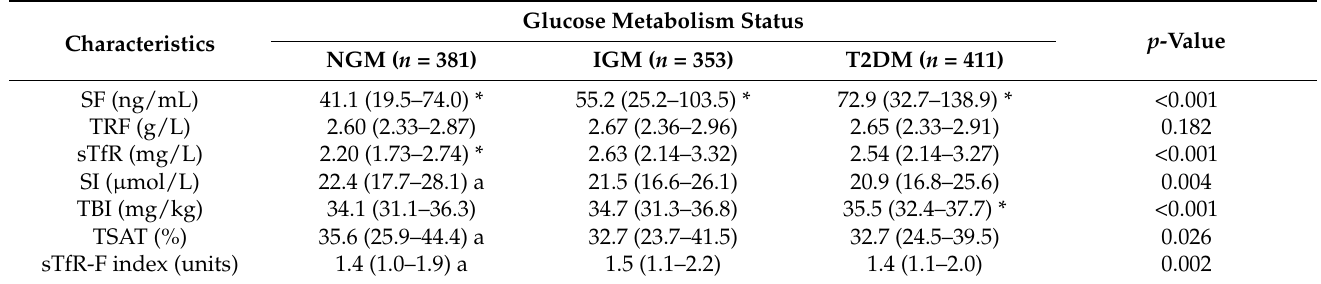
Table 2. Characteristics of the iron status of the studied population (medians and interquartile ranges (P 25 –P 75 )).